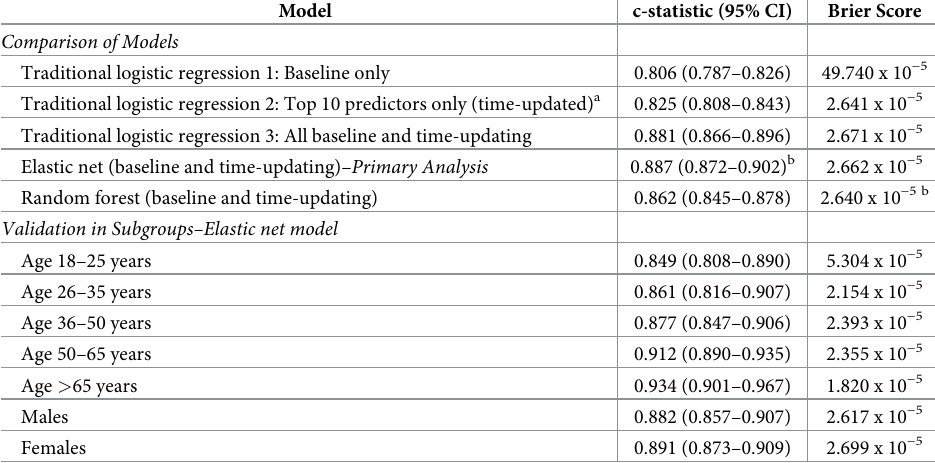
Random forest (baseline and